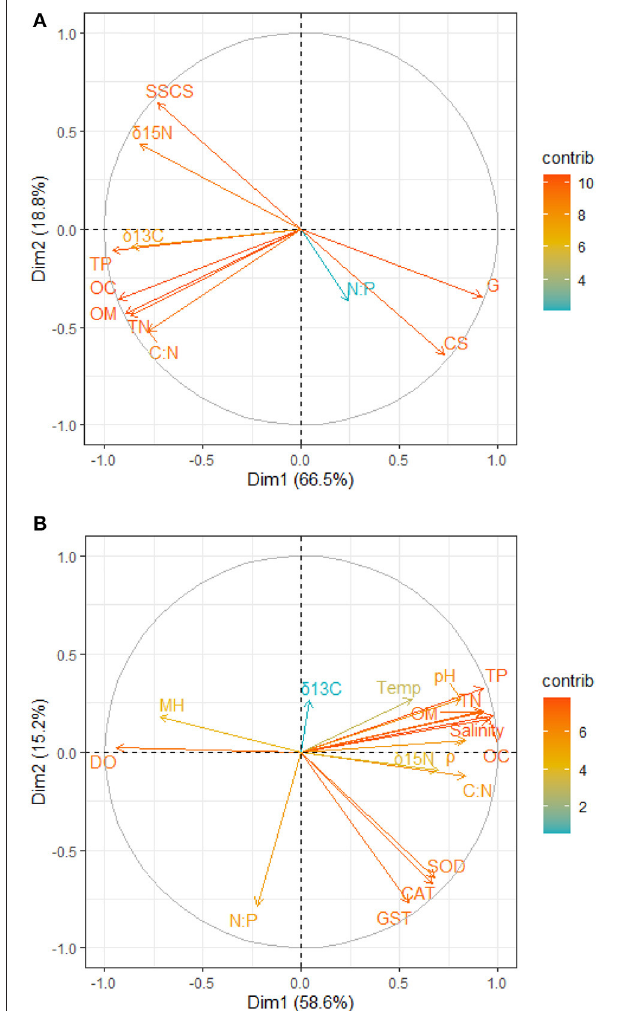
FIGURE 2 | Principal component analysis contribution plot for the relationship between (A) sediment grain size and nutrients (B) nutrients, physicochemical parameters, antioxidants, and mangrove height. OC, Percentage of organic carbon; TN, Total nitrate; TP, Total phosphate; C:N, Carbon-Nitrogen ratio; N:P, Nitrogen-Phosphorus ratio; δ 13 C, Carbon isotope; δ 15 N, Nitrogen isotope; CS, Coarse sandy; SSCS, Clay and Silt particles; G, Gravels; CAT, Catalase; GST, Glutathione–S–transferase; SOD, Superoxide dismutase; ρ , Density; DO, Dissolve oxygen; Temp, Temperature; MH, Mangrove height.